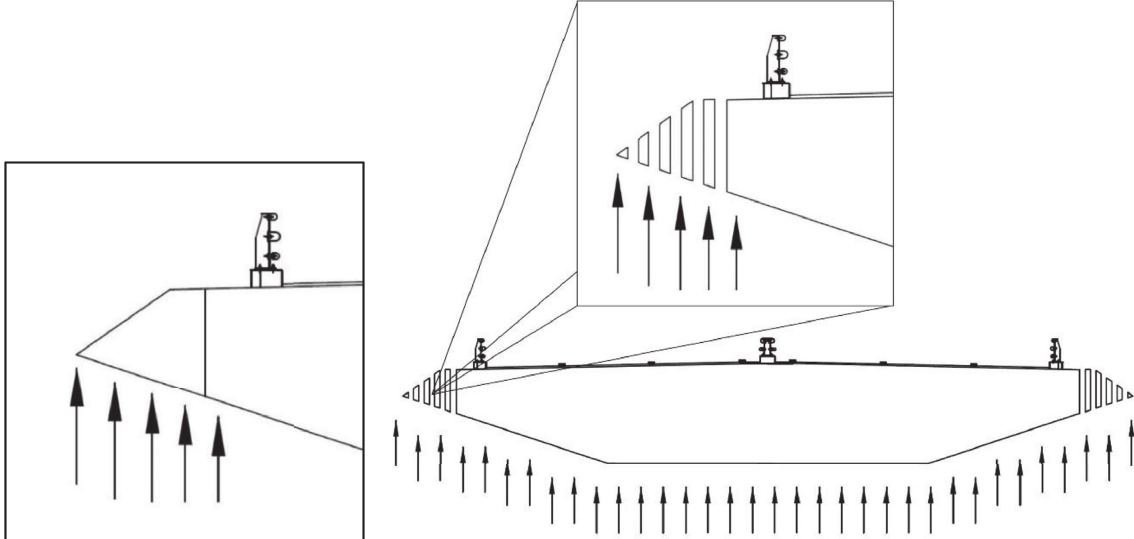
l : (a) laminar flow; (b) turbulent flow.